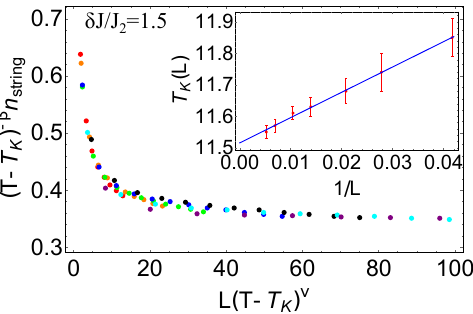
Figure 28: Data collapse demonstrating a second-order Pokrovsky-Talapov phase transition. The = 1.5. Simulations are model in question is H ABB2 [ Eq. 69 ] in the constrained manifold and δ J / J 2 run on hexagonal clusters with N = 3 L 2 and L = 24 (red), L = 36 (orange), L = 48 (green), L = 72 (blue), L = 96 (black), L = 144 (cyan), L = 192 (purple). The data are plotted according to the scaling hypothesis given in Eq. 9, and the best collapse is found for β = 0.47 ± 0.04 and ν (cid:107) = 1.05 ± 0.09. This is consistent with β = 1 / 2 and ν (cid:107) = 1, which are the expected values for a second-order Pokrovsky- Talapov transition. The inset shows the scaling of the critical temperature, which follows Eq. 87.